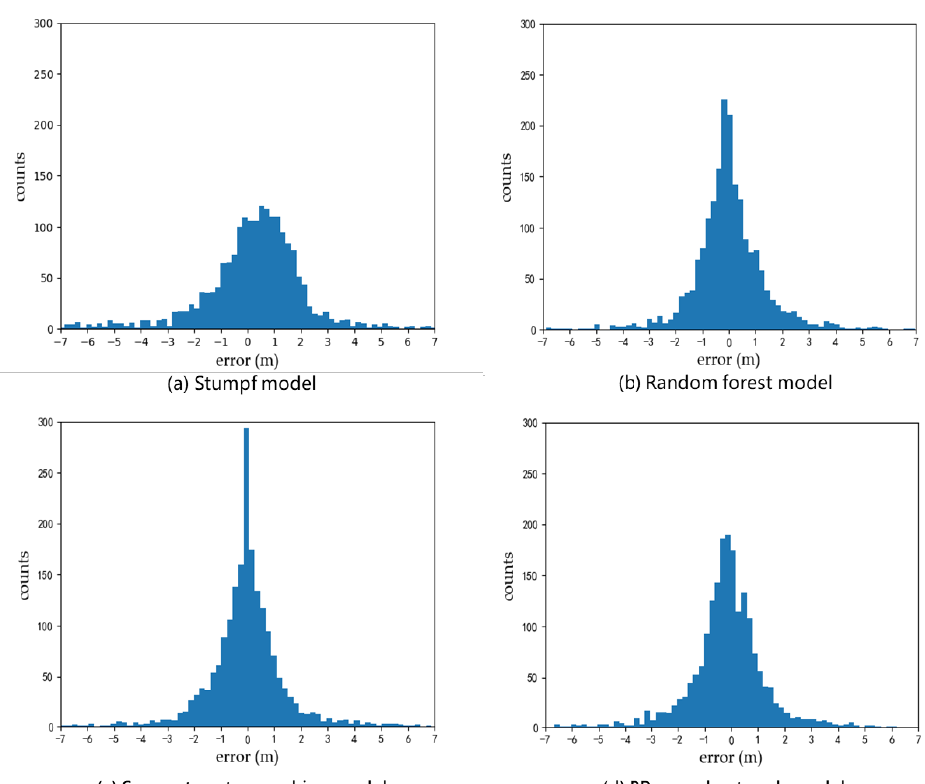
Figure 5. ( a - d ) Model error distribution histograms. Figure 5. ( a – d ) Model error distribution